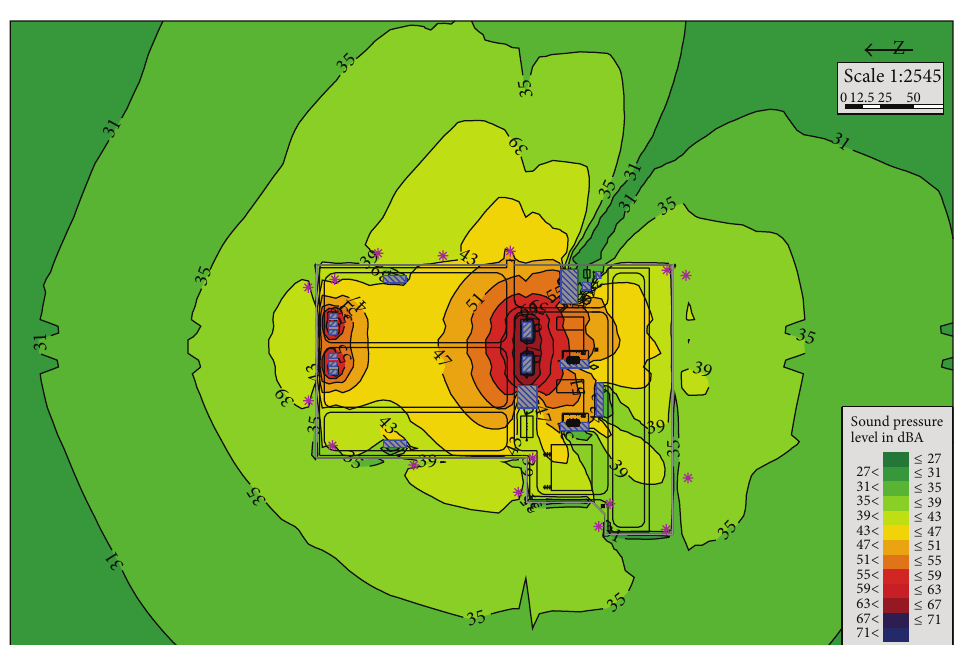
Figure 6: Substation noise distribution in Plan